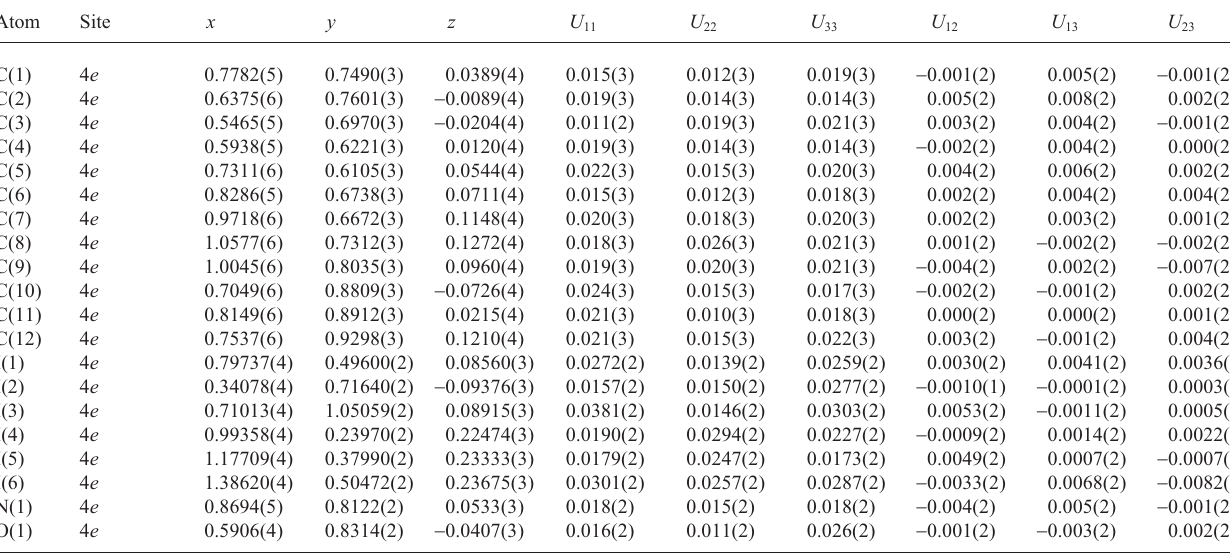
Table 3. Atomic coordinates and displacement parameters (in Å 2 )